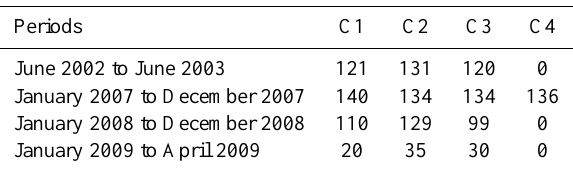
Table 1. Contribution of each spacecraft to statistics, according to analysed